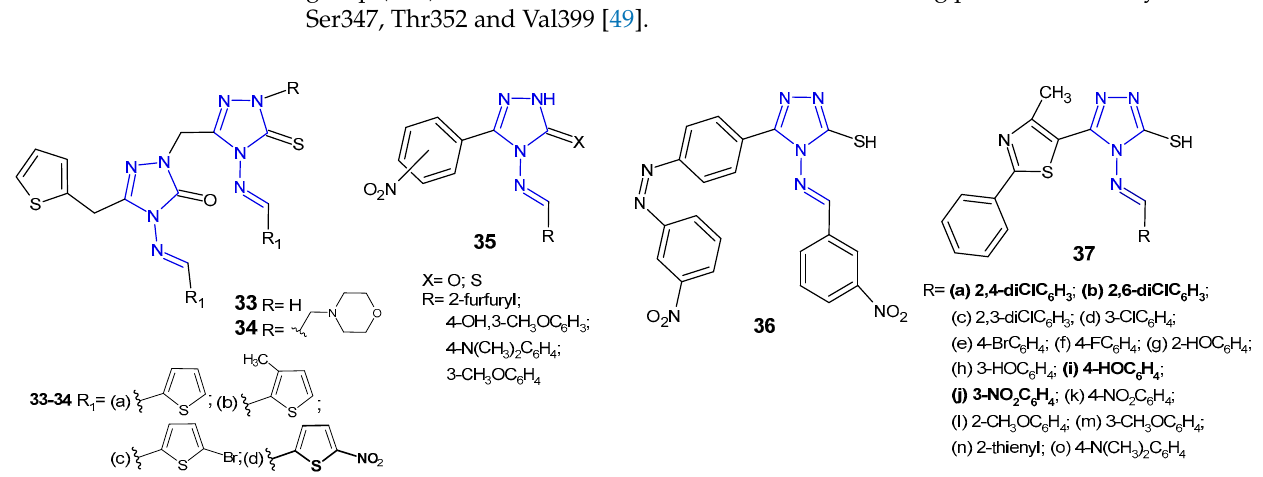
Figure 13. Antibacterial Schiff bases of 1,2,4-triazole –